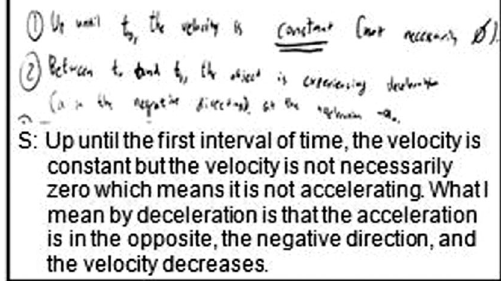
FIG. 4. Interpretation of acceleration-time graph (question